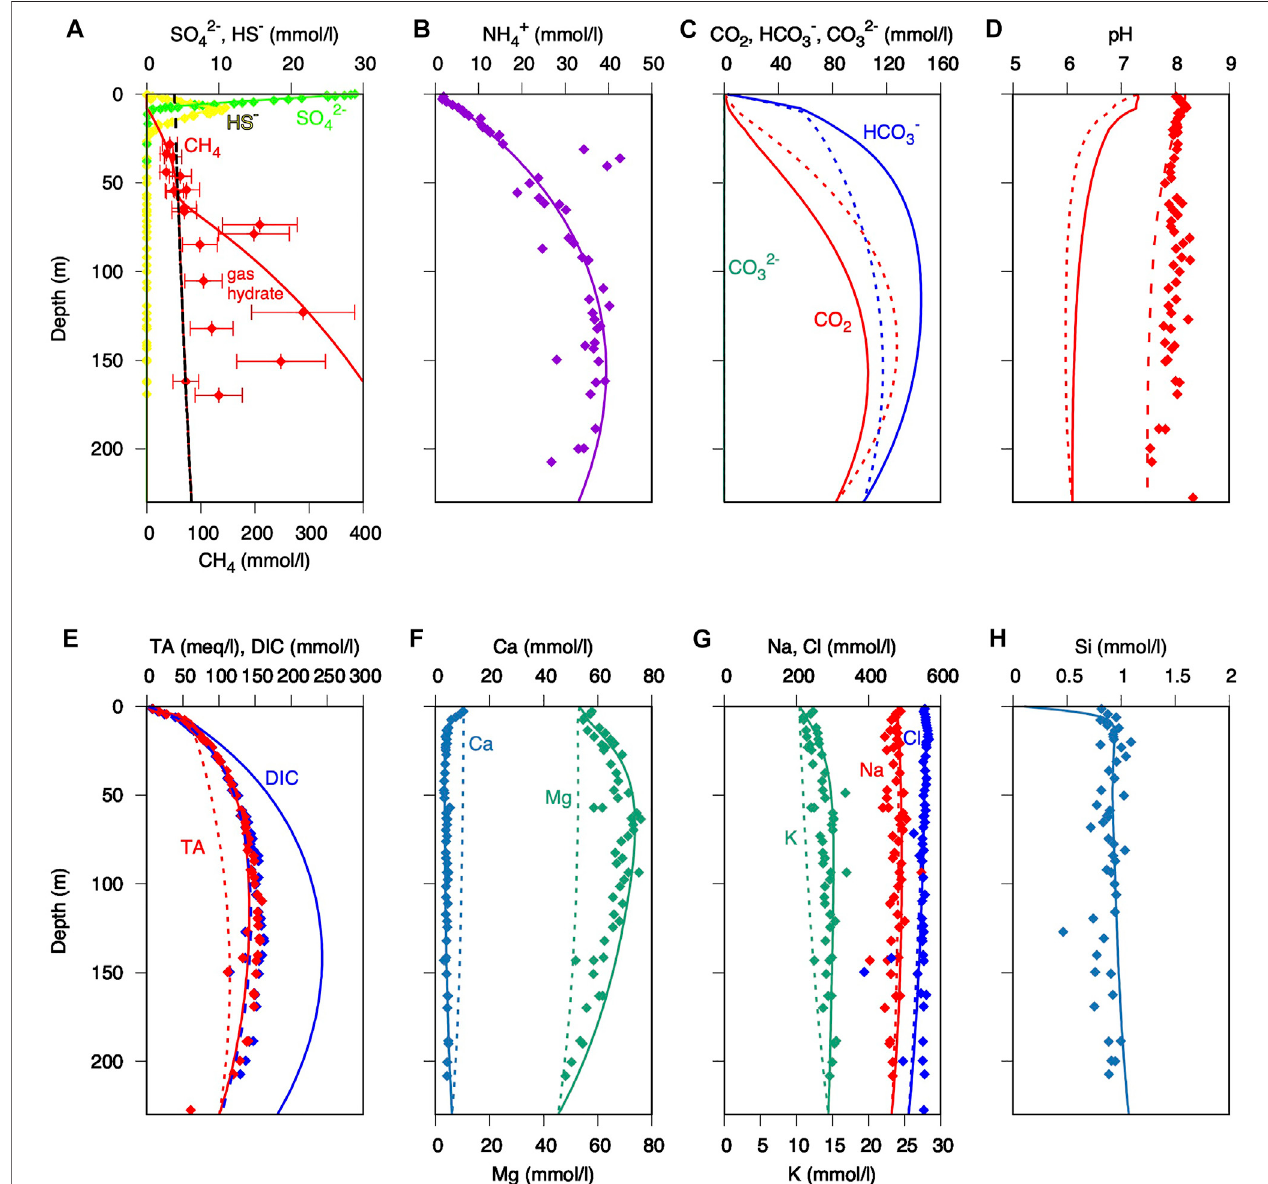
FIGURE 5 | Measured (solid symbols) and simulated porewater concentration pro fi les (lines) vs. depth: (A) sulphate and methane; (B) ammonium; (C) inorganic carbonspecies; (D) pH(dashedline:afterequilibrationwithheadspace); (E) dissolvedinorganiccarbonandtotalalkalinity; (F) CaandMg; (G) K,Na,andCl;and (H) total Si. All concentrations are reported in mmol/L. Dotted lines: simulation including microbial reactions; solid lines: simulation including microbial and mineral reactions. Measured data are from D ’ Hondt et al. (2003) and Donohue et al. (2006).